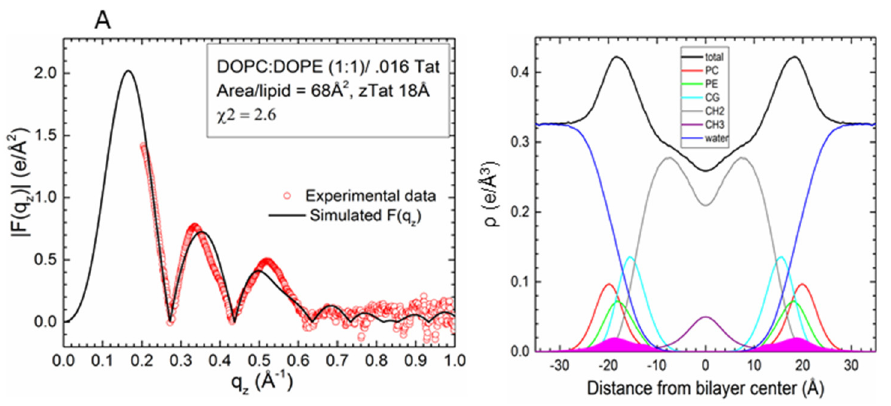
Figure 4. Detailed comparison of |F(q z )| ( left ) between neat DOPC:DOPE (1:1) experimental data points (open red circles) and simulation |F(q z )| (black line) at the A L that yielded the smallest χ 2 (A L = 66 Å 2 , χ 2 = 2.3). Experimental data were scaled to the simulated |F(q z )|. Electron density profile ( right ) from the same simulation with component groups indicated in the figure legend. PC, phosphatidylcholine and PE, phosphatidylethanolamine headgroups; CG, carbonyl-glycerol; CH2, methylenes and methines in hydrocarbon chains; CH3, terminal methyl group.